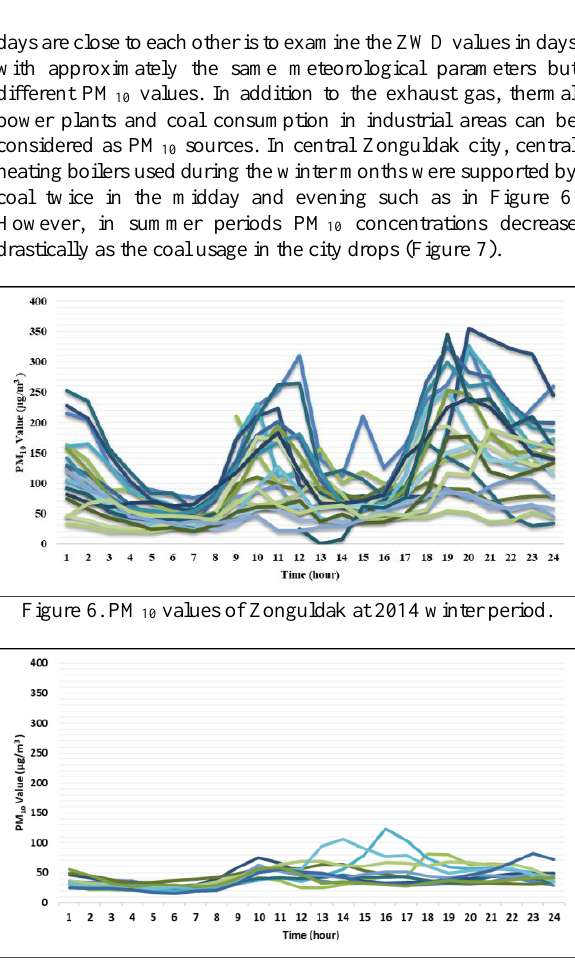
Figure 7. PM 10 values of Zonguldak at 2015 summer